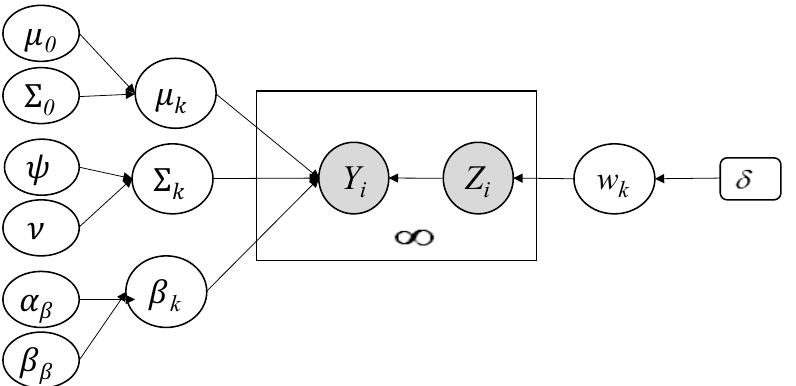
Figure 2. Graphical representation of our developed Bayesian infinite multivariate generalized Normal mixture model. Fixed hyperparameters are indicated by rounded boxes and random variables by circles. Y is the observed variable, Z is the latent variable, large boxes indicate repeated process, and the arcs show the dependencies between